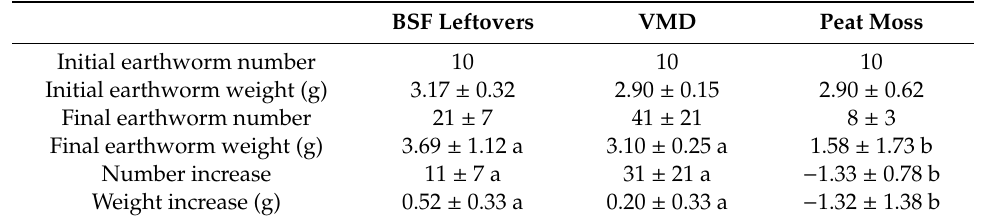
Table 8. Growth parameters of earthworms reared on BSF rearing leftovers, VMD, or simple peat moss